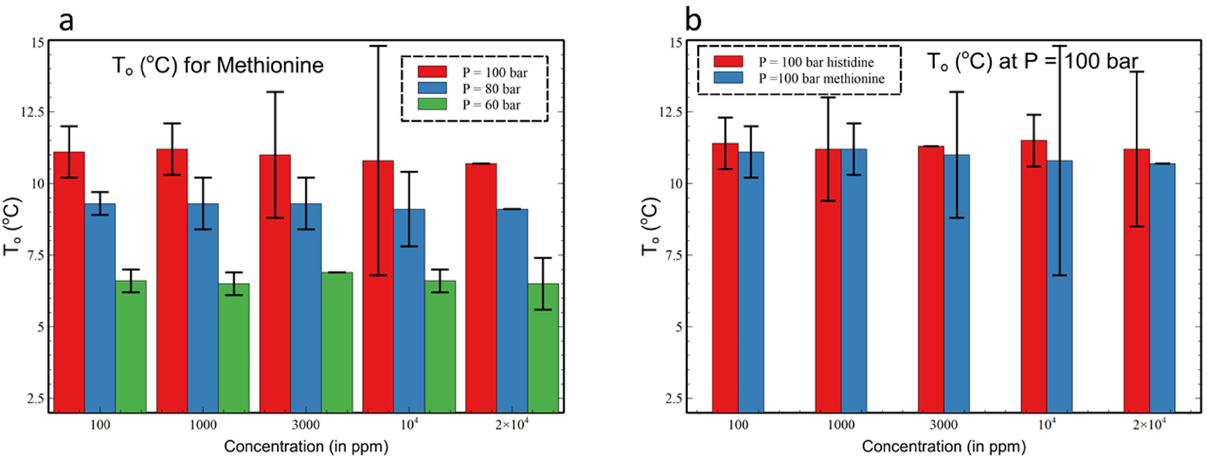
Figure 5. Initial nucleation temperature (T 0 ) calculated from the constant ramping temperature scheme in the presence of L-histidine and L-methionine for different concentrations for a fresh run. ( a ) Onset temperature variation for L-methionine for different concentration at P = 60, 80 and 100 bar. ( b ) T 0 variation at 100 bar for histidine and methionine. Margin of error was calculated for 90% confidence interval using t distribution.